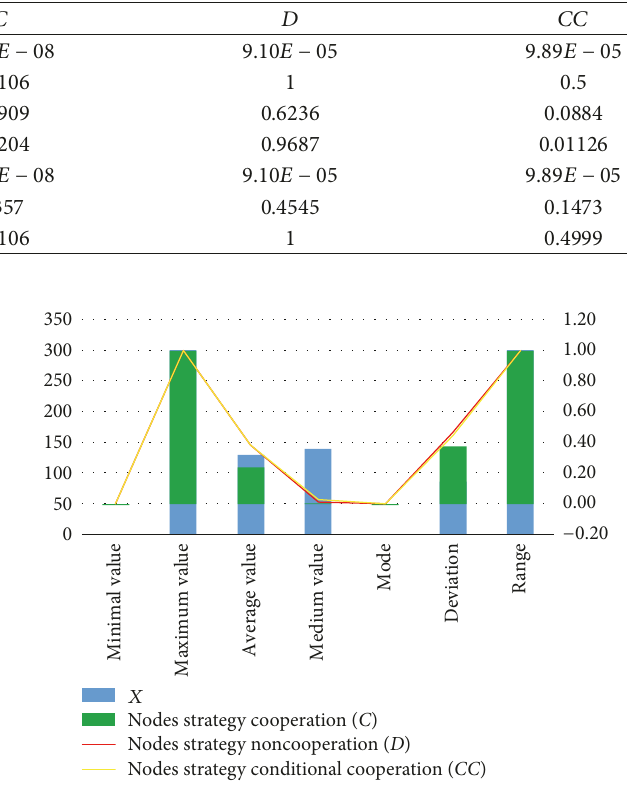
Figure 12: The state of population when 𝑋 = (0, 300, 130.2, 139.4, 0, 86.78,